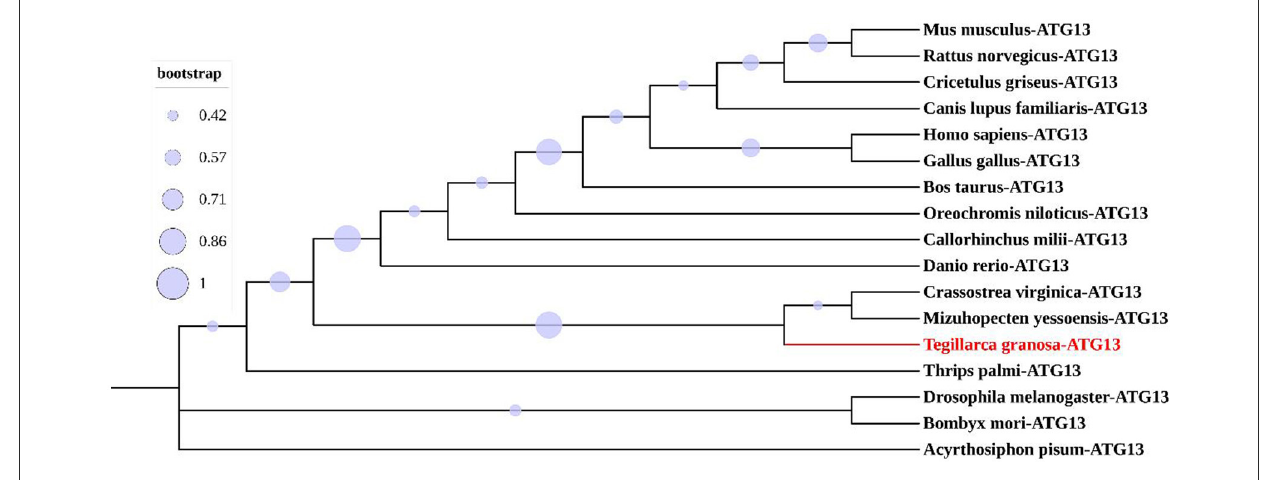
FIGURE3 Phylogenetic analysis of ATG13 HORMA domains from different species.